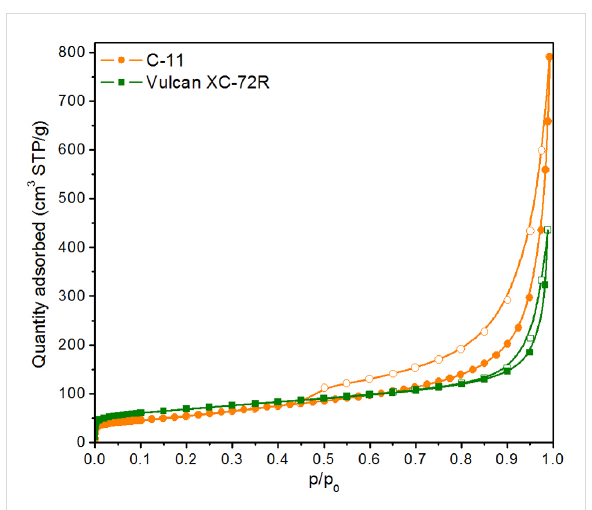
Figure 2: N 2 adsorption–desorption curves for synthesized C-11 and commercial Vulcan XC-72R carbon materials.